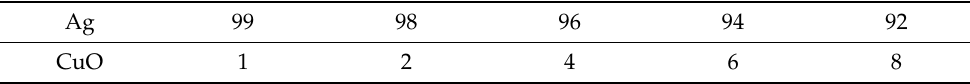
Figure 1. ( a ) SEM image of the microstructure of TiAl substrate. ( b ) XRD pattern of TiAl substrate. Table 1. Filler alloy composition used in this study